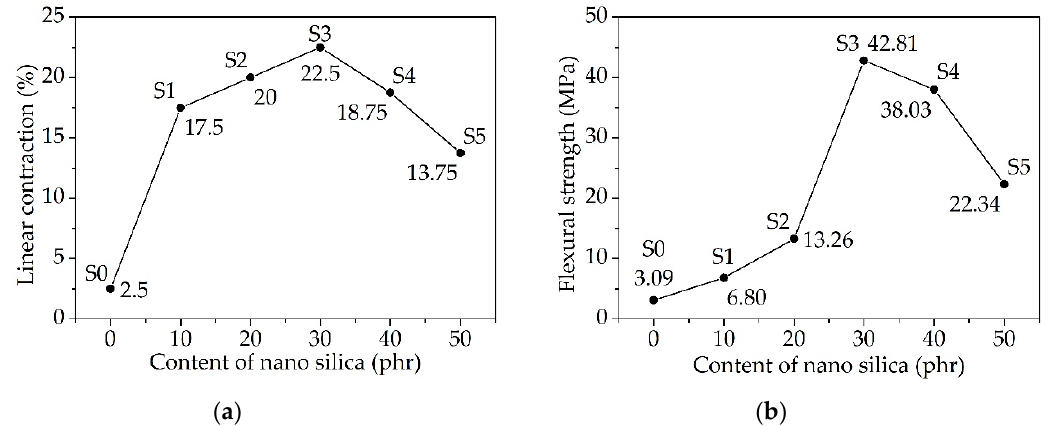
Figure 6. Properties of ceramic samples with different contents of nano silica: ( a ) linear contraction; ( b ) flexural strength.